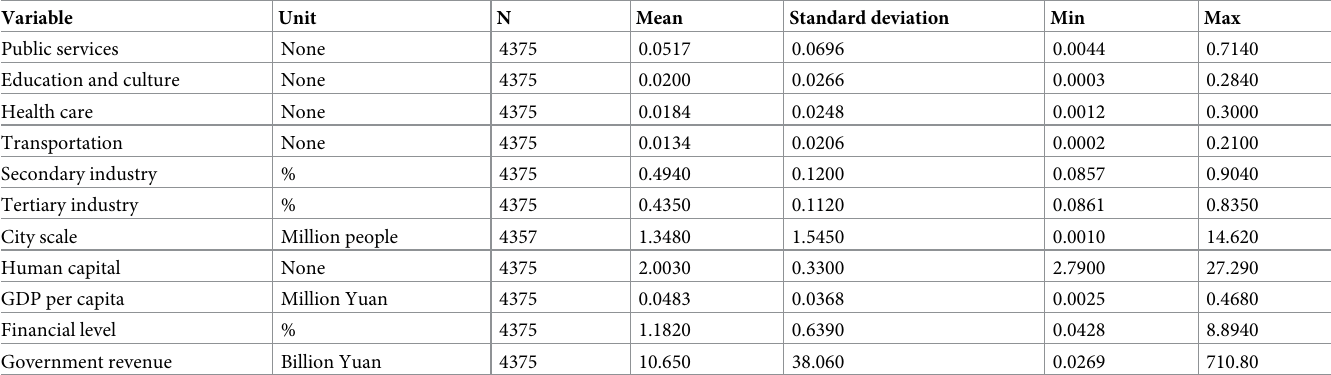
Table 2. Descriptive statistics of